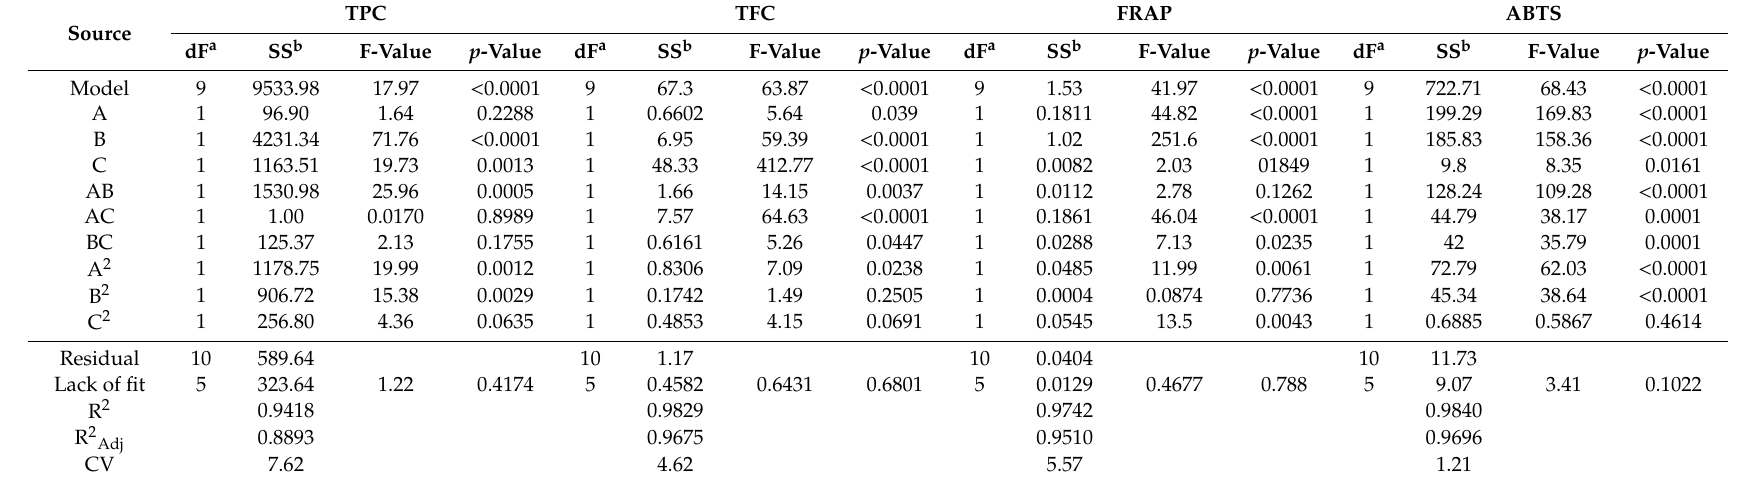
Table 1. Analysis of Variance (ANOVA) of regression equation for optimization of TPC, TFC, FRAP, and